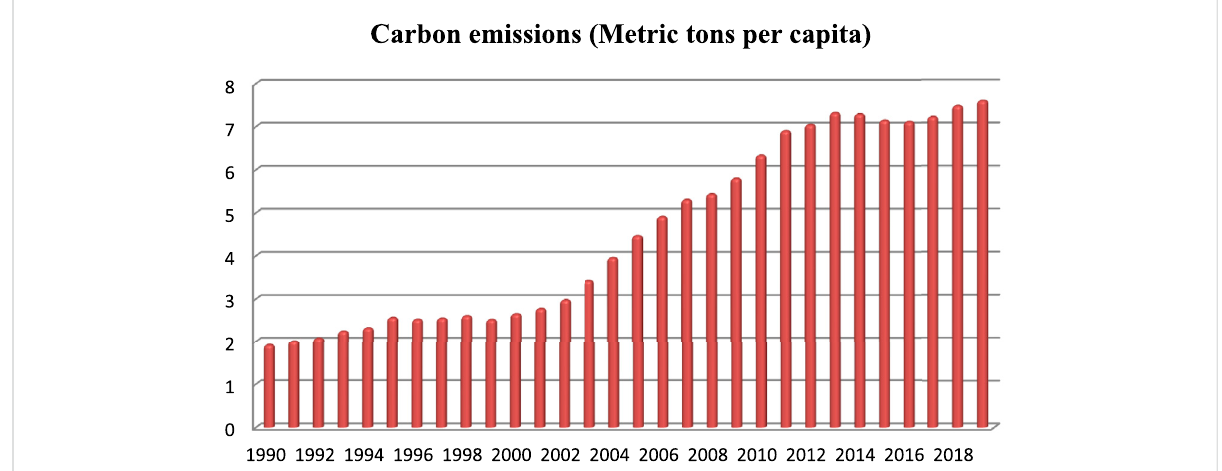
FIGURE 1 A graphical fi gure of the CO 2 trend inChina ’ s